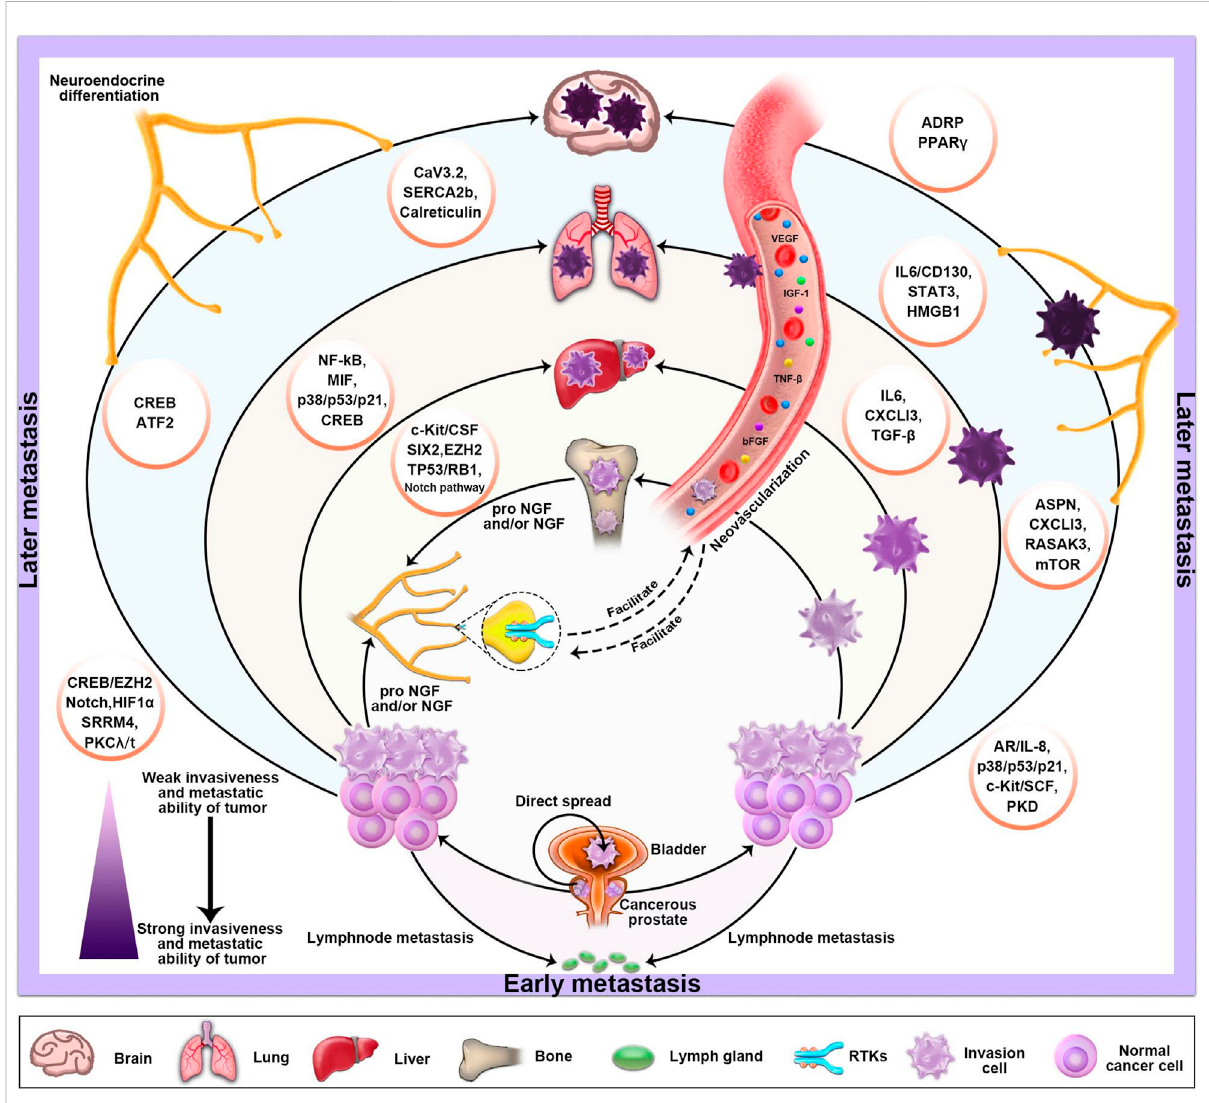
FIGURE 5 The basic metastatic sites and pathways of PC and the factors which in fl uence its NED and neovascularization. The progression of PC depends on stimulation of the autonomic nervous system. Sympathetic nerve releases norepinephrine (NA) in the tumor microenvironment, activating the adrenergicnervesignal, which is necessary intheearlystages oftumor growth andangiogenesis. Moreover,thevariousmolecular mechanismsthat primarily mediate NED are also described in the